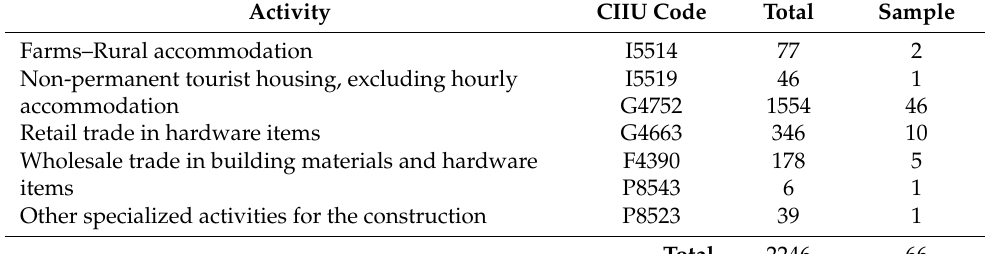
Table 3. Target population and sample size calculated for the market study of the start-up of a nonconventional plastic sand cobbles plant in the city of Ibague—Colombia.